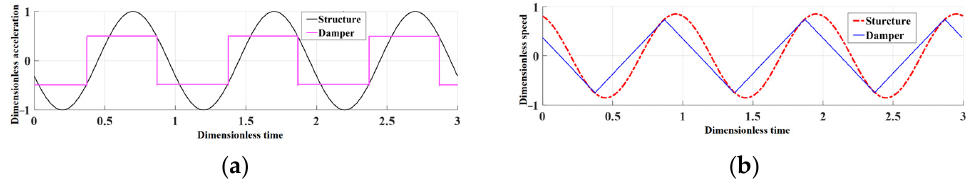
Figure 9. Motion at θ = 12° in stick–slip state ( k = 0.5): ( a ) Acceleration; ( b ) Velocity.